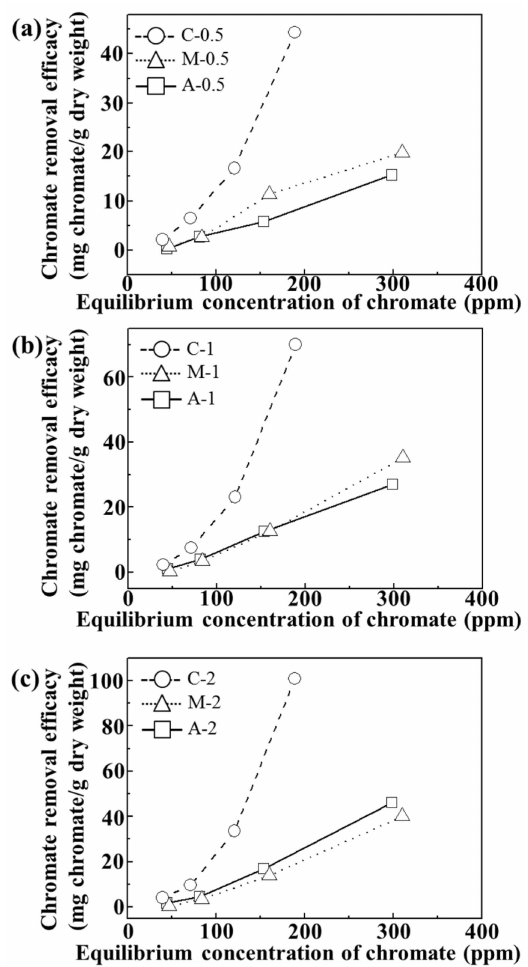
Figure 5. Isotherms of chromate removal efficacy (mg chromate/g dry weight) of agarose only (A), LDH-agarose mixture (M) and LDH-agarose composite (C) samples for ( a ) 0.5 wt/v%; ( b ) 1 wt/v%; and ( c ) 2 wt/v% agarose-based materials. The experiments were carried out at pH 7.2 ˘ 0.3 after 24